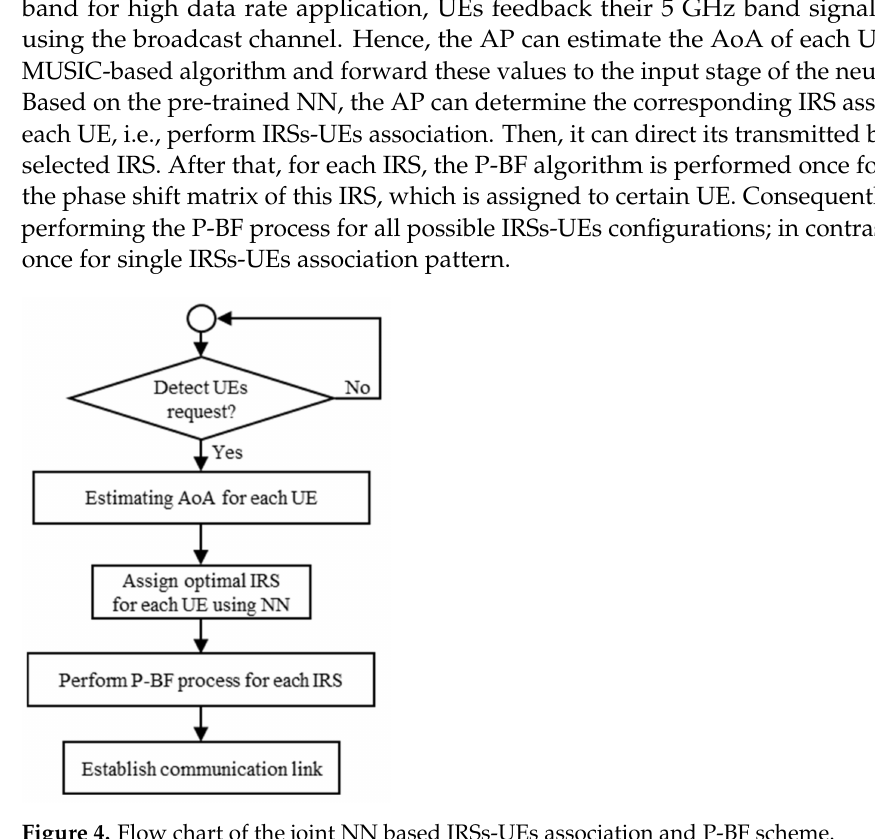
Figure 4. Flow chart of the joint NN based IRSs-UEs association and P-BF